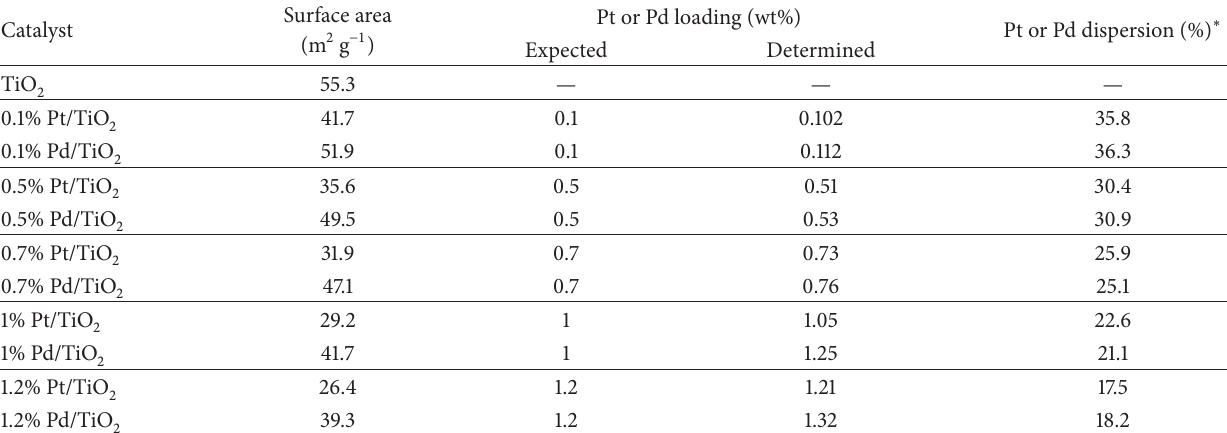
Table 2: Surface characteristics of Pt/TiO 2 and Pd/TiO 2 used for the photocatalytic oxidation of toluene.